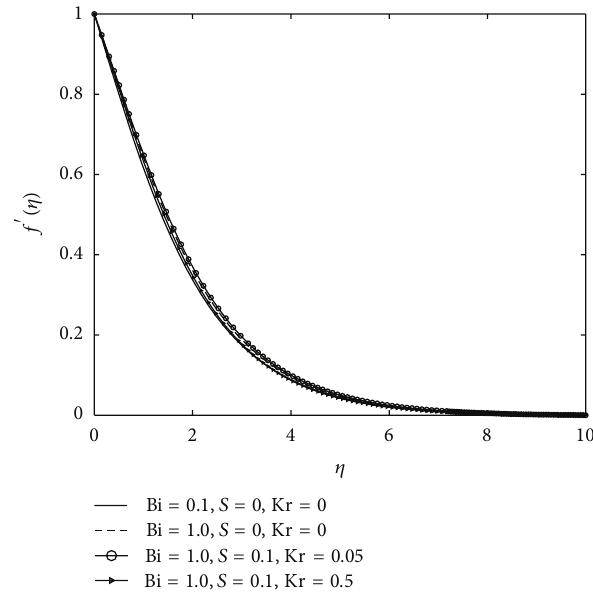
Figure 3: Velocity profiles for different values of Bi, 𝑆 , and Kr for Ha = 0.1 , Gr = 0.1 , Gc = 0.1 , Sc = 0.62 , Nc = 0.01 , and Pr = 0.72 .